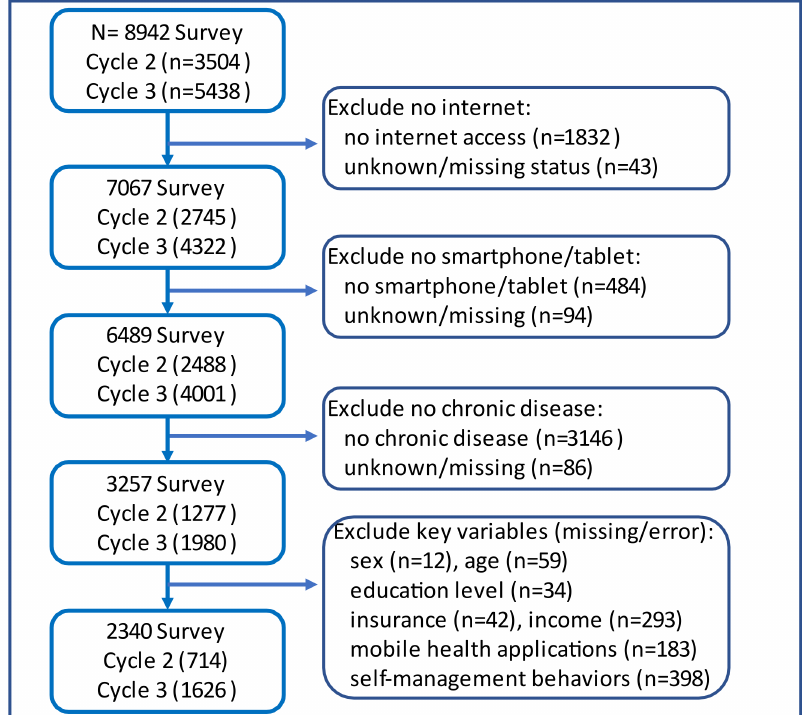
Figure 1. Study Flow